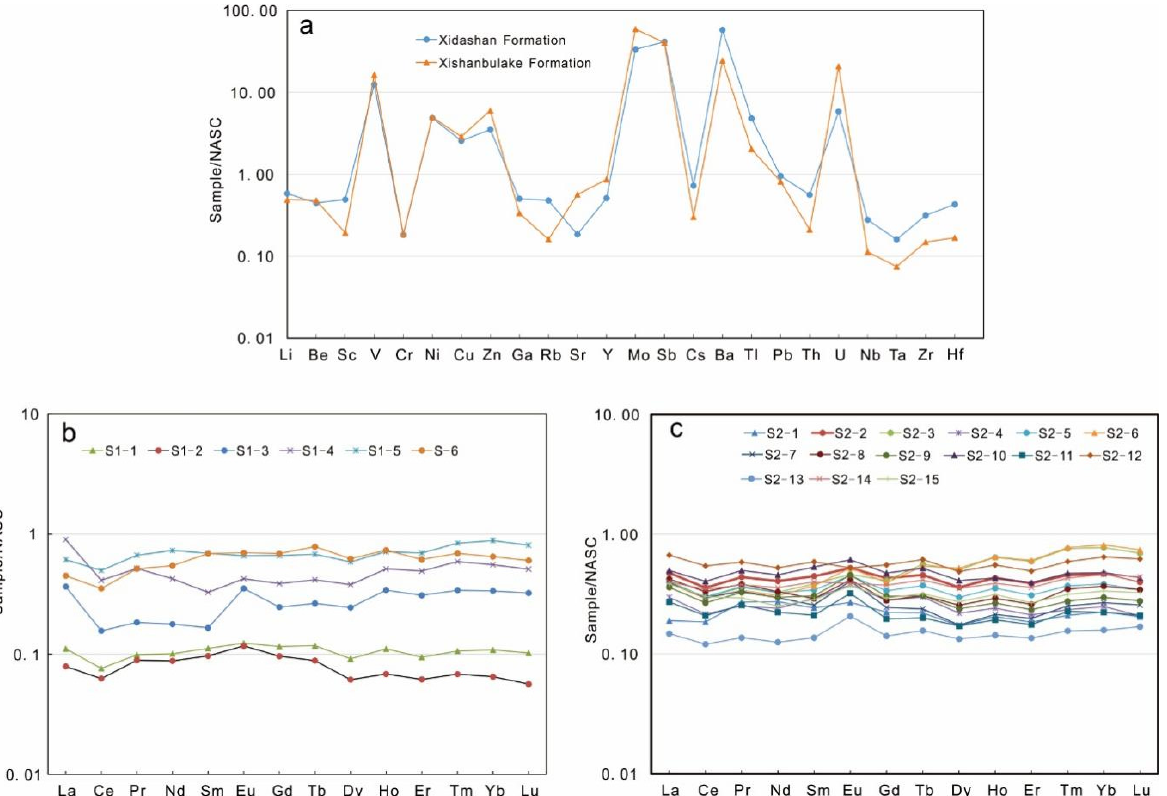
Figure 2. ( a ) UCC-normalized trace element spider diagrams; ( b ) NASC-normalized REE distribution pattern of Xishanbulake Formation mudstone; ( c ) NASC-normalized REE distribution pattern of Xidashan Formation mudstone, Kongquehe area.